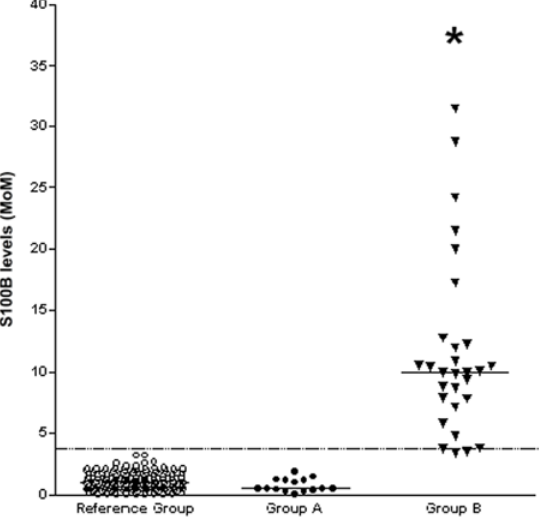
Figure 1. Saliva levels of S100B were significantly higher in asphyxiated full-term newborns with severe (Group B, black triangle) than in those with good (Group A, black circles) neurological outcome at follow-up and in healthy controls (Reference Group, open circles). The horizontal solid lines indicate the median values for each group; the horizontal dotted line indicates the cut-off point (critical value) with the most reliable separation between infants who suffered severe long-term neurological sequelae and those who did not and controls. * P < 0.001 vs healthy controls and asphyxiated newborns with absent or mild